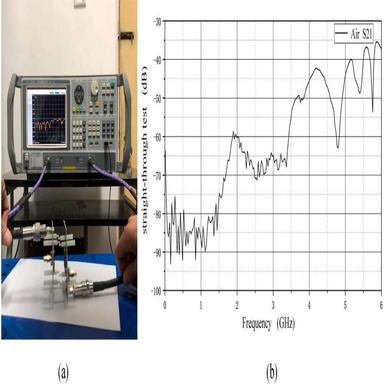
Microstrip antenna fixture straight-through (air SE) test: (a) actual measurement; (b) 10 MHz∼6 GHz S21(r).